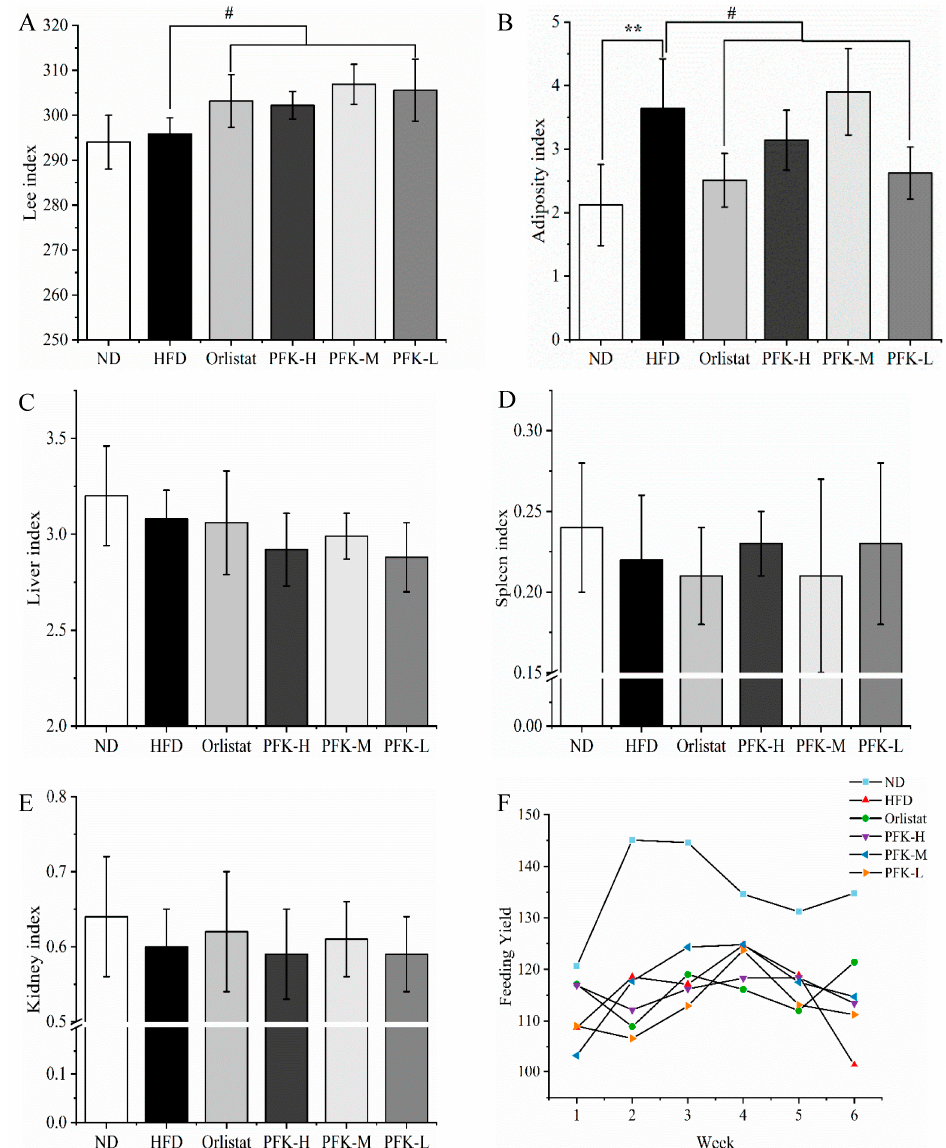
Figure 2. Effects of PFK on body index. ( A ) Lee’s index, ( B ) adiposity index, ( C ) liver index, ( D ) spleen index, ( E ) kidney index, and ( F ) feeding yield. ND group: normal diet + 0.5% CMC-Na; HFD group: high-fat diet + 0.5% CMC-Na; Orlistat group: high-fat diet + 20 mg/kg orlistat; PFK-H group: high-fat diet + 400 mg/kg krill oil, 40 mg/kg fucoxanthin, 200 mg/kg phycobiliprotein; PFK-M group: high-fat diet + 200 mg/kg krill oil, 20 mg/kg fucoxanthin, 100 mg/kg phycobiliprotein; PFK-L group: high-fat diet + 100 mg/kg krill oil, 10 mg/kg fucoxanthin, 50 mg/kg phycobiliprotein. The values were reported as the mean ± SD of rats per group. ** p < 0.01, # p <